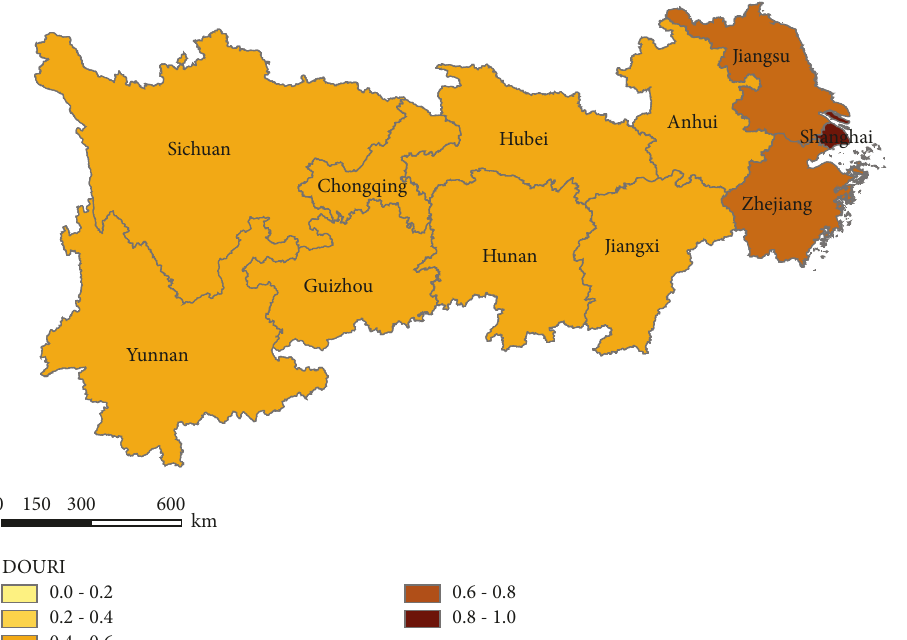
Figure 3: Spatial distribution map of the urban-rural integration degree of the Yangtze River Economic Belt in 2020.